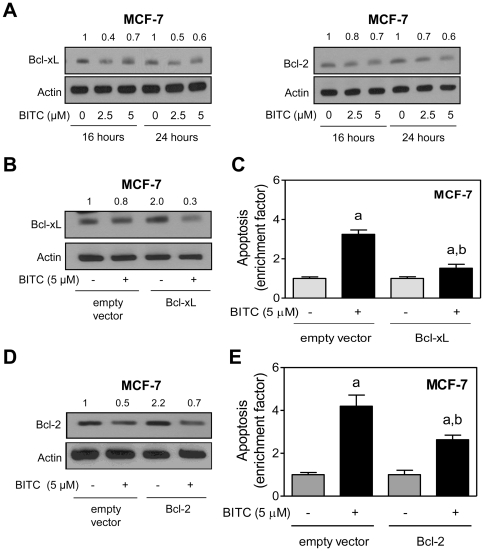
Overexpression of Bcl-xL and Bcl-2 confers protection against BITC-induced apoptosis in MCF-7 cells.(A) Western blotting for Bcl-xL and Bcl-2 using lysates from MCF-7 cells treated with DMSO (control) or BITC (2.5 or 5 µM) for the indicated time periods. Number above band indicates change in level compared to the corresponding DMSO-treated control. (B) Western blotting for Bcl-xL using lysates from MCF-7 cells transiently transfected with empty vector or Bcl-xL plasmid and treated for 24 h with DMSO or 5 µM BITC. Number above band represents change in level relative to empty vector transfected cells treated with DMSO (first lane). (C) Quantitation of histone-associated DNA fragment release into the cytosol in MCF-7 cells transiently transfected with empty vector or vector encoding for Bcl-xL and treated for 24 h with DMSO or 5 µM BITC. (D) Western blotting for Bcl-2 using lysates from MCF-7 cells transiently transfected with empty vector or Bcl-2 plasmid and treated for 24 h with DMSO or 5 µM BITC. Number above band represents change in level relative to empty vector transfected cells treated with DMSO (first lane). (E) Quantitation of histone-associated DNA fragment release into the cytosol in MCF-7 cells transiently transfected with empty vector or vector encoding for Bcl-2 and treated for 24 h with DMSO or 5 µM BITC. Data in C, E are expressed as enrichment relative to corresponding DMSO-treated control (mean ± SD, n = 3). Significantly different (P<0.05) acompared with corresponding DMSO-treated control, and bbetween empty vector transfected cells and Bcl-xL or Bcl-2 overexpressing cells by one-way ANOVA followed by Bonferroni's multiple comparison test. The experiments were repeated twice and data from one representative experiment are shown.